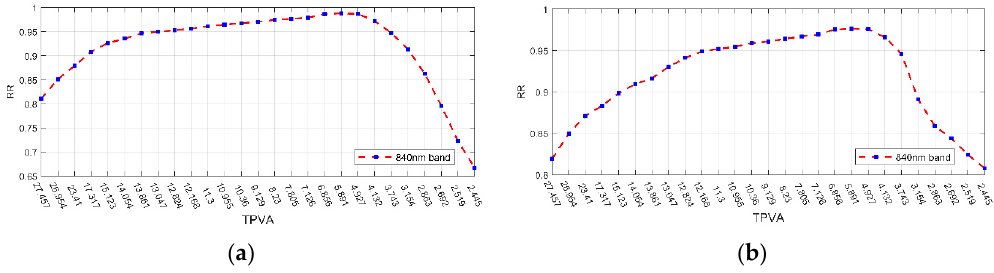
Figure 12. Recognition rates (RR) with different acutance TPVA on a single band of HPV with different local texture patterns. Results using the feature extraction methods of ( a ) CompCode; ( b ) deep features.